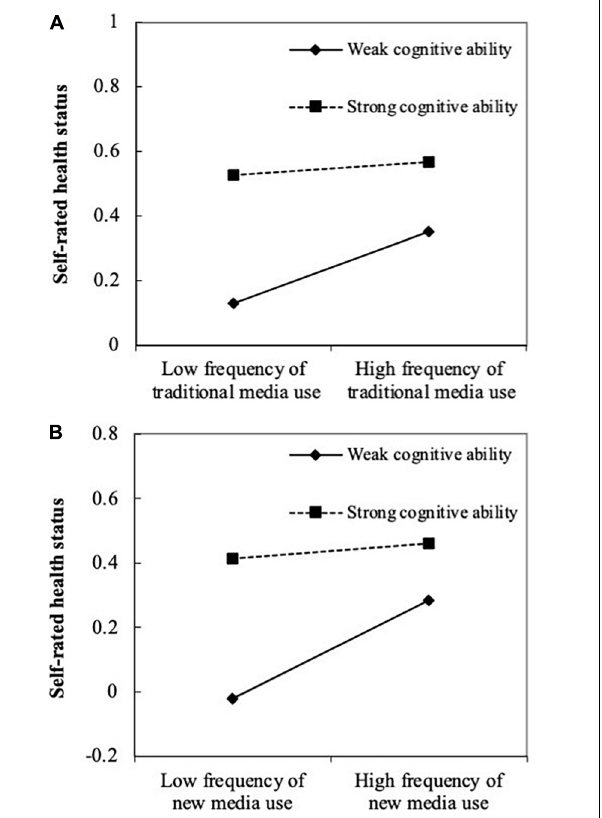
FIGURE 3 | Moderating effect of cognitive ability on media use to self-rated health status. (A) Traditional media use; (B) new media use.